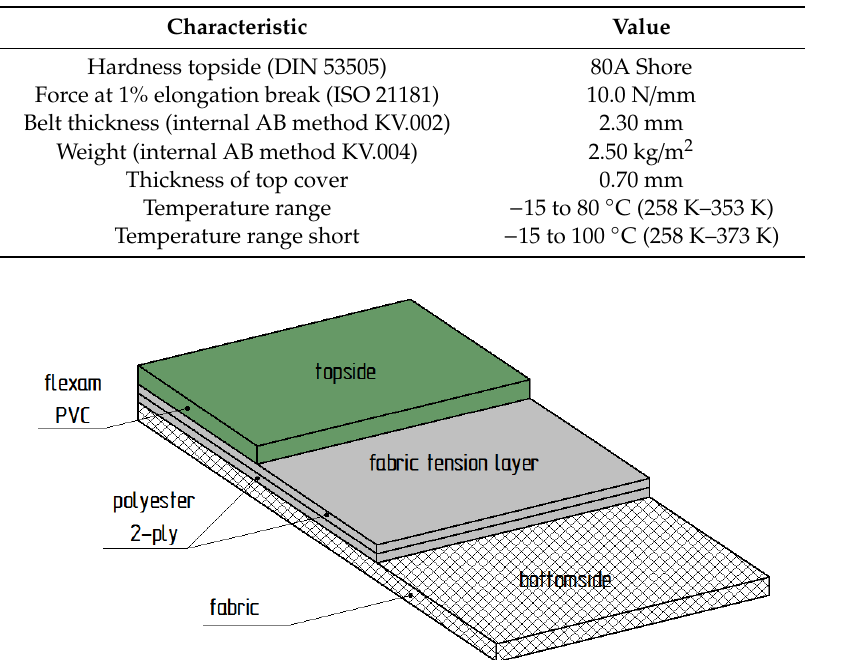
Figure 2. Structure of the tested conveyor belt.